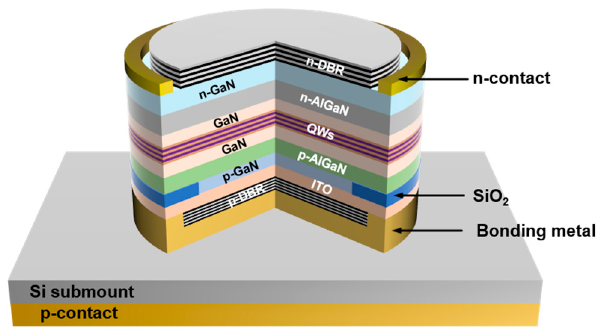
Figure 1. Schematic diagram of the GaN-based RCLED.